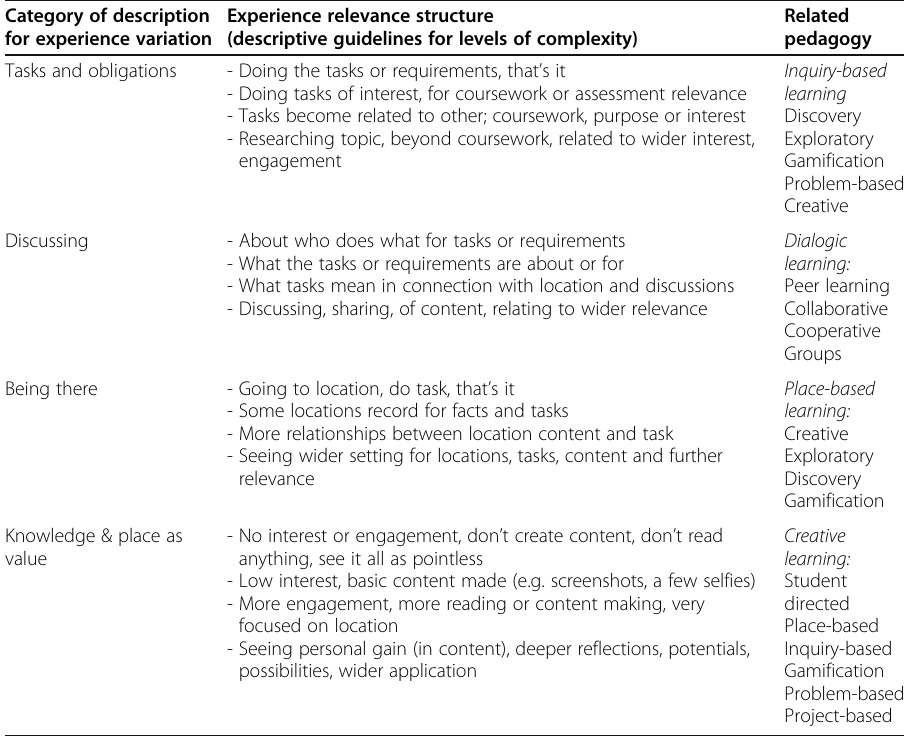
Related pedagogy